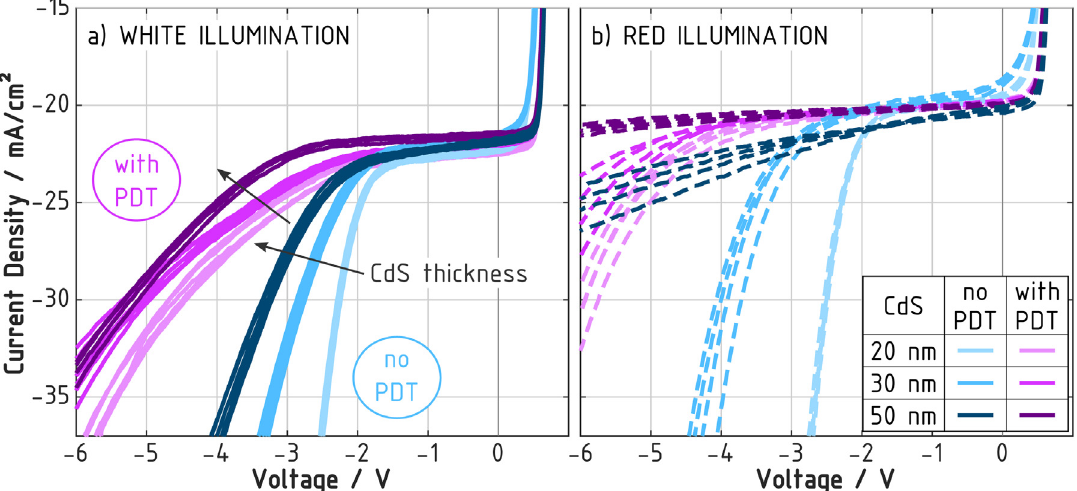
Fig. 1. IV characteristics of samples without PDT (blue) and with PDT (pink) and with different CdS buffer layer thicknesses under (a) white illumination and (b) red illumination (longpass- fi ltered above 600 nm). Four to six samples per cell type are